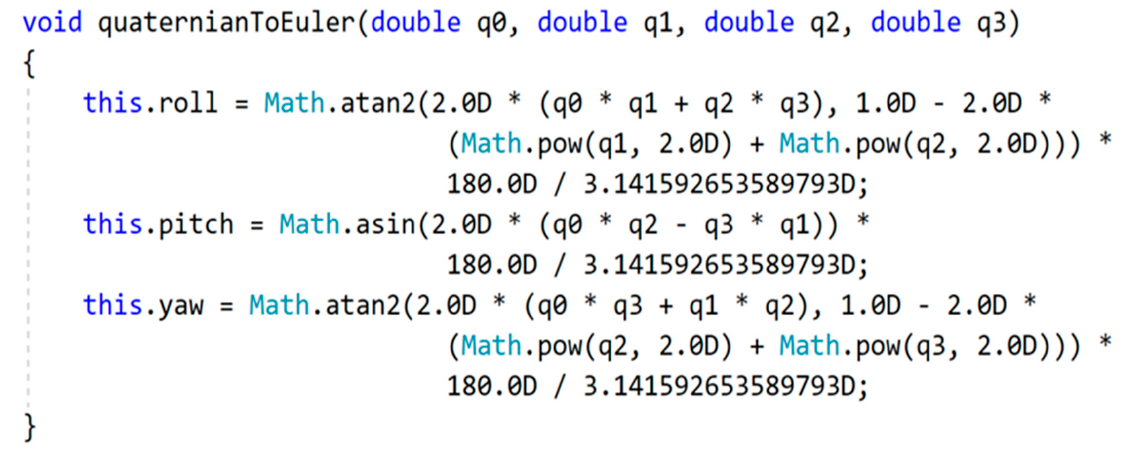
Figure 5. Code sample for calculating the roll, pitch and yaw .